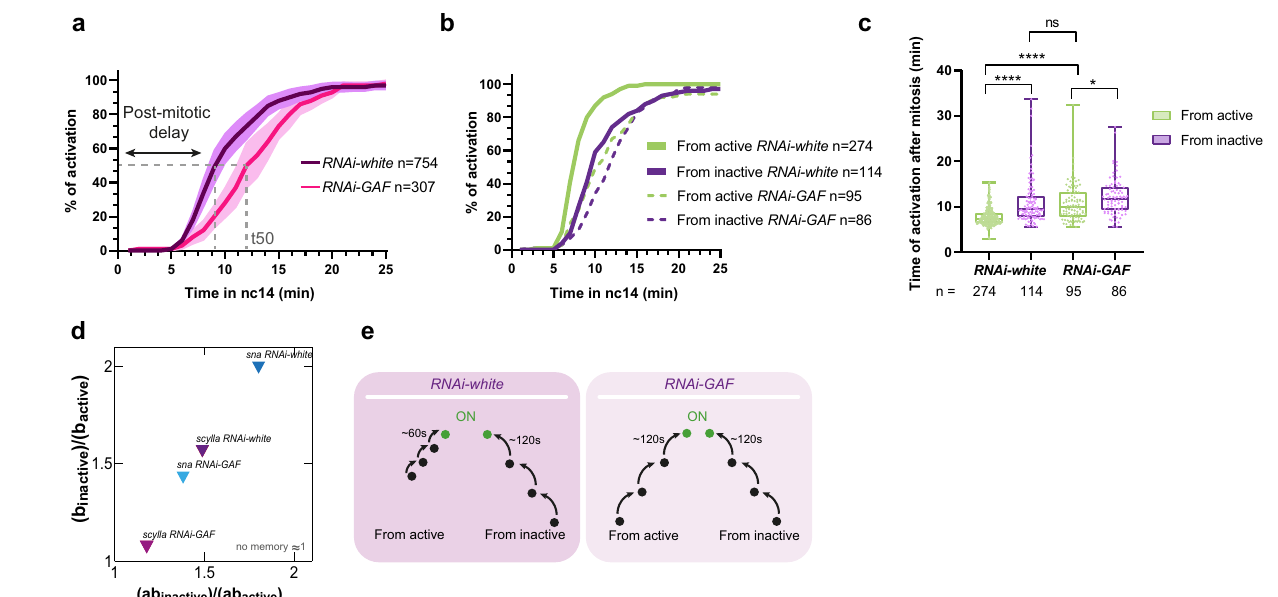
Fig. 5 GAF is required for transcriptional memory of Scylla . a Quanti fi cation of transcriptional synchrony of scylla_24X-MS2_CRISPR/ + embryo after mitosis in RNAi-white (control, purple) and mat-alphaTub-Gal4/ + ; nos-Gal4/UASp-shRNA-GAF embryos (pink). The dashed line represents the t50 where 50% of the pattern is activated during nc14. Both of the two daughters derived from each nucleus are quanti fi ed. SEM are represented in light purple and light pink. n = number of nuclei analyzed from four movies of four independent embryos for each condition. b Cumulative activation of the fi rst activated nuclei coming from active nuclei (green) and from inactive (purple) in RNAi-white embryos (control, solid curves) and RNAi-GAF scylla_24X-MS2_CRISPR/ + embryos (dashed curves). n = number of pooled nuclei analyzed from four movies of four embryos. c Box plot representing the mean time of the fi rst activation after mitosis of nuclei derived from active (green) and inactive (purple) nuclei in RNAi-white embryos and RNAi-GAF scylla_24X-MS2_CRISPR/ + embryos. The centered horizontal line represents the median, whiskers represent min and max values. Two-tailed Welch ’ s t test **** P < 0.0001, * P = 0.0252. d Ratios of parameter “ b ” and “ ab ” in subpopulations from inactive and active nuclei of scylla_24X-MS2_CRISPR/ + (purples) and snail-primary- enhancer_MS2 (blues) in RNAi-white or RNAi-GAF embryos. The parameter “ a ” corresponds to the average number of transitions (provided by the sum of weighted probabilities) and the parameter “ b ” to the time of each jump from one state to another. e Schematic of the proposed role of GAF in transcriptional memory. In the presence of GAF, nuclei derived from active nuclei have shorter “ b ” length than those derived from inactive nuclei whereas in the absence of GAF, both have the same transition